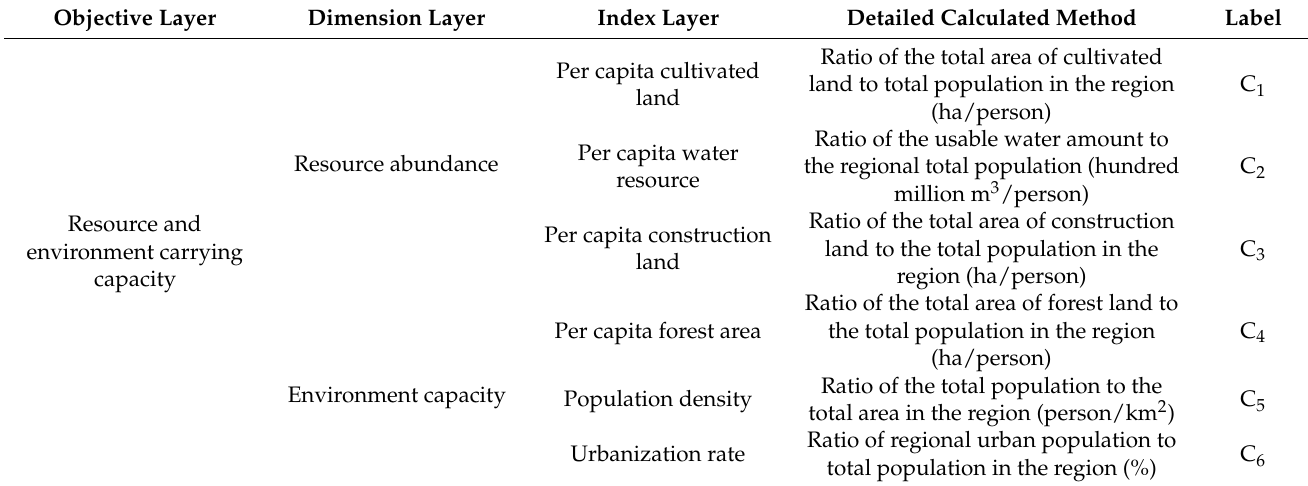
Table 3. Integrated evaluation index system of regional resource and environment carrying capacity. Objective Layer Dimension Layer Index Layer Detailed Calculated Method